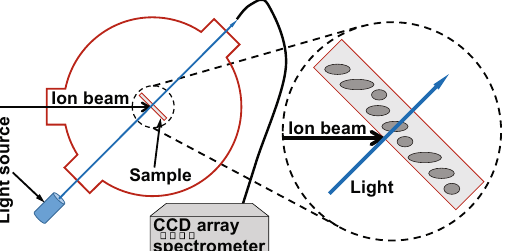
Figure 6. Schematic representation of the setup used for in situ transmittance measurements. Samples can be irradiated with swift heavy ions and simultaneously illuminated with white light (blue arrows). Transmitted light is collected by an optical fiber and guided to a CCD array